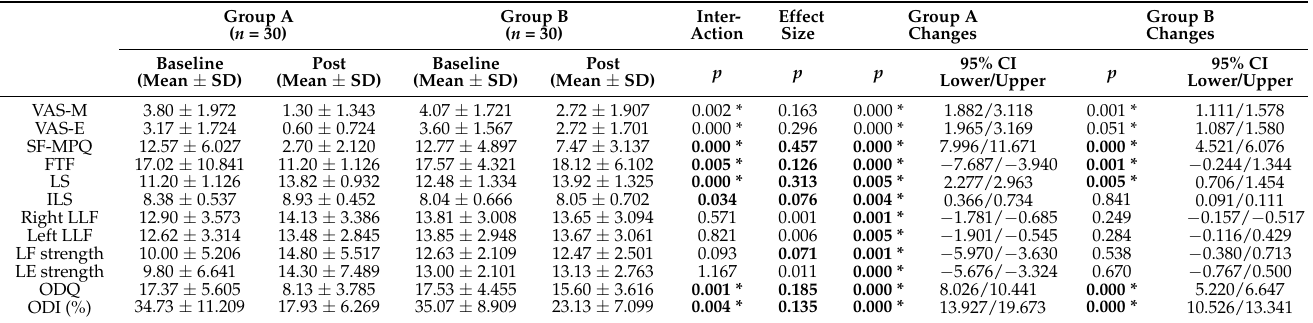
Table 3. Changes expressed as crude values in the pain intensity (VAS and SF-MPQ), lumbar spine mobility (FTF, LS, ILS, Right LLF, Left LLF, LF, LE) and disability level (ODQ and ODQ%) [confidence interval 95%]. Effect